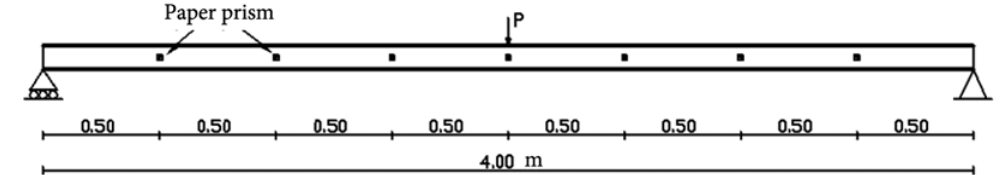
Fig. 2. The beam, loading, and locations of the deflection